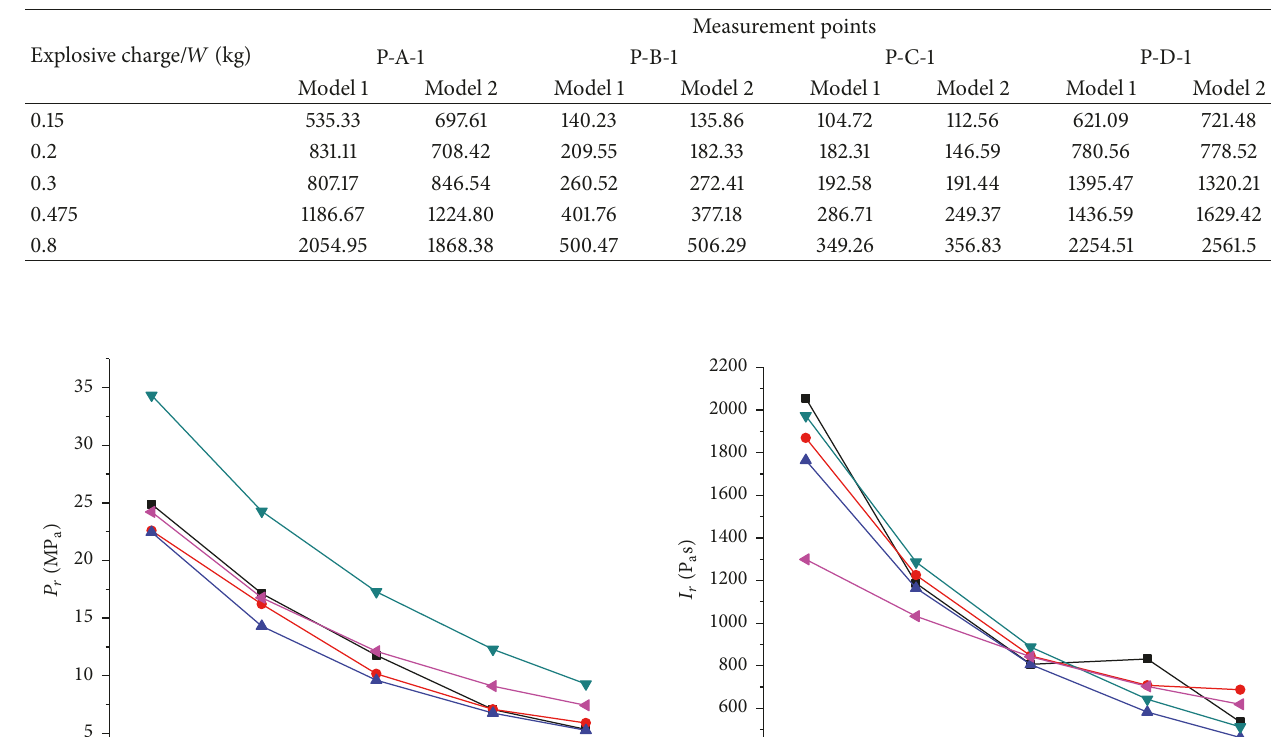
Table 6: The reflected specific impulse of the internal explosion (P a ⋅ s).